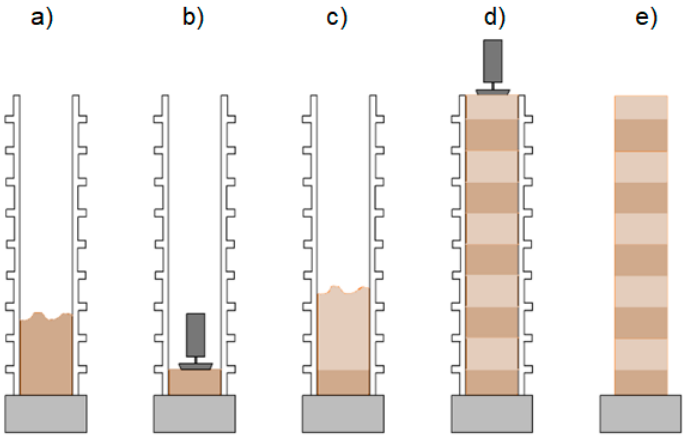
Figure 4. A scheme for erecting a wall using rammed earth technology. Different layers of the CARE monolithic wall are marked with different colors. Steps when erecting a wall: ( a ) Formwork is built and filled with a layer of moist soil-cement mixture. ( b ) The layer of moist mixture is compressed. ( c ) The next layer of moist soil-cement mixture is added. ( d ) Successive layers of moist earth are added and compressed. ( e ) The formwork is removed leaving the monolithic CSRE wall.